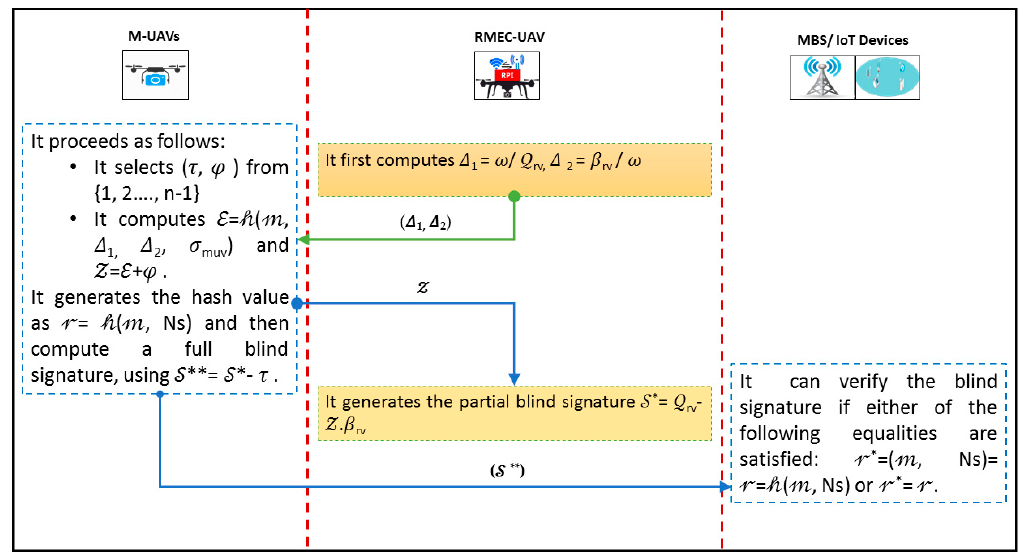
Figure 4. Signing and verifying phase.